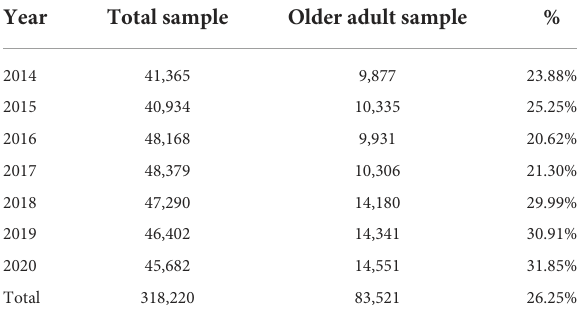
TABLE 1 The total sample and the older adults’ sample size from 2014 to